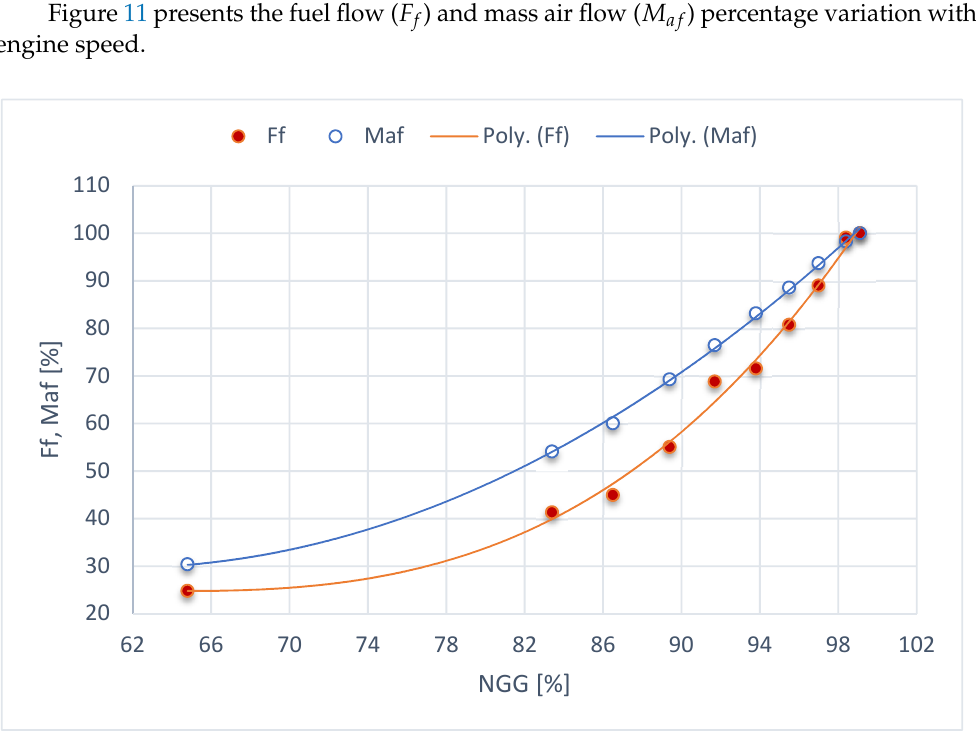
Figure 11. Fuel flow and mass air flow percentage variation.